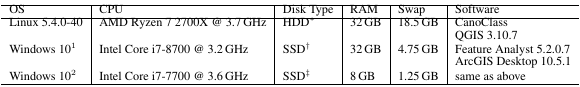
Table 1. System specifications for our case study with CanoClass (Linux) and Feature Analyst by Cho et al. (2020) (two Windows 10s). All systems are 64 bits. 1: Windows system 1. 2: Windows system 2. *: 5400rev/min. † : 3200MB/s sequential read, 2400MB/s sequential write. ‡ : 550MB/s sequential read, 535MB/s sequential